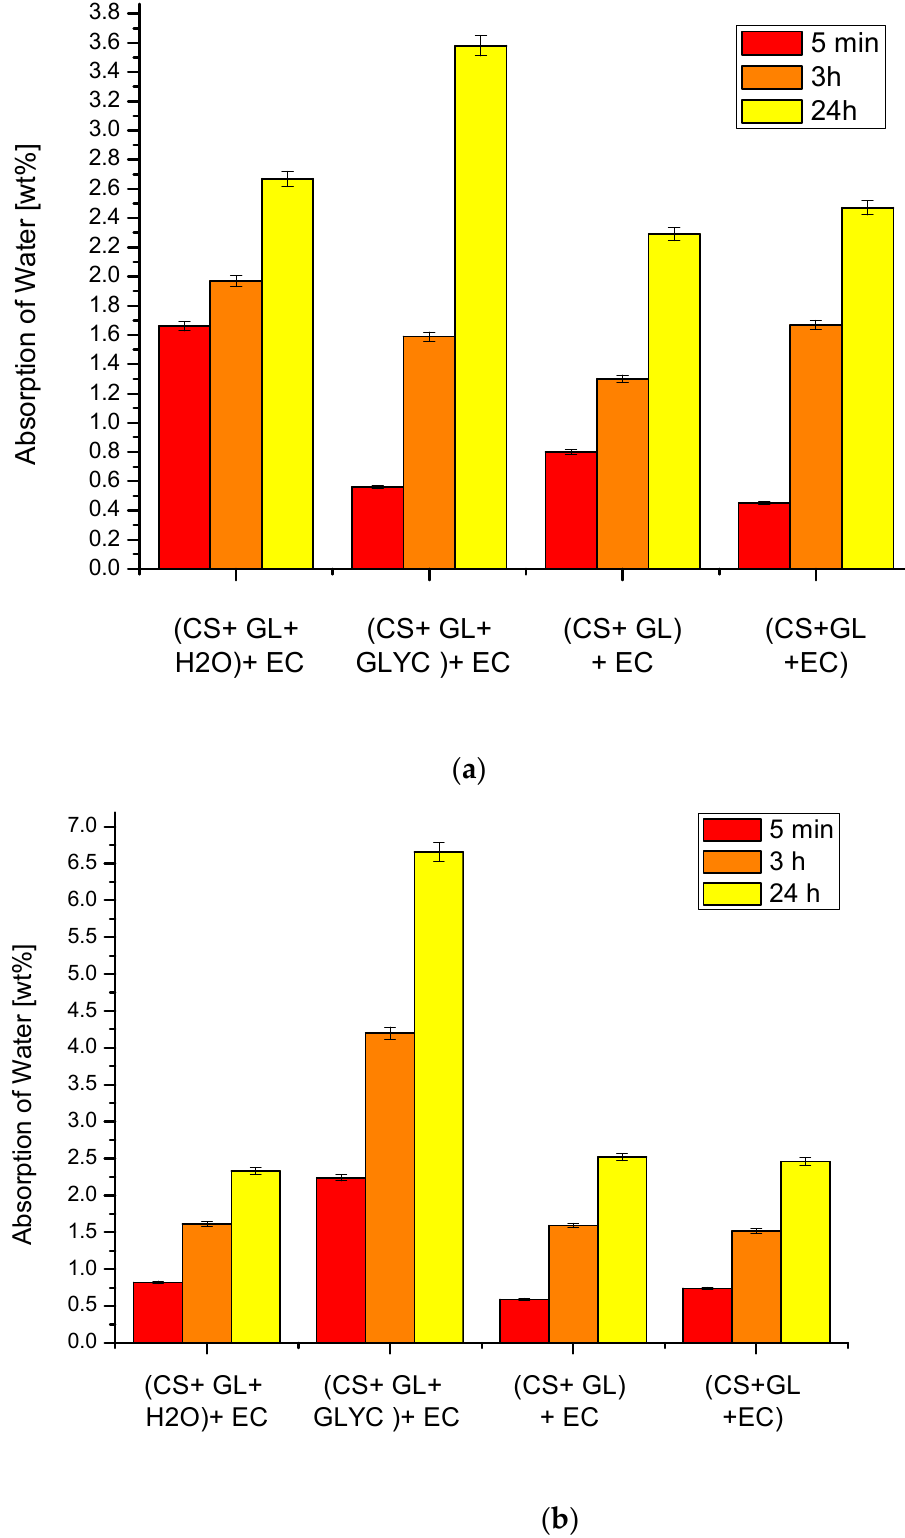
Figure 7. Absorption of water of the obtained polyurethane foams with 2% ( a ) and 3% ( b ) foaming agent (determined with ± 1.9% accuracy). The appropriate shade of color indicates the time the foam stayed in the water (shown in the insert).